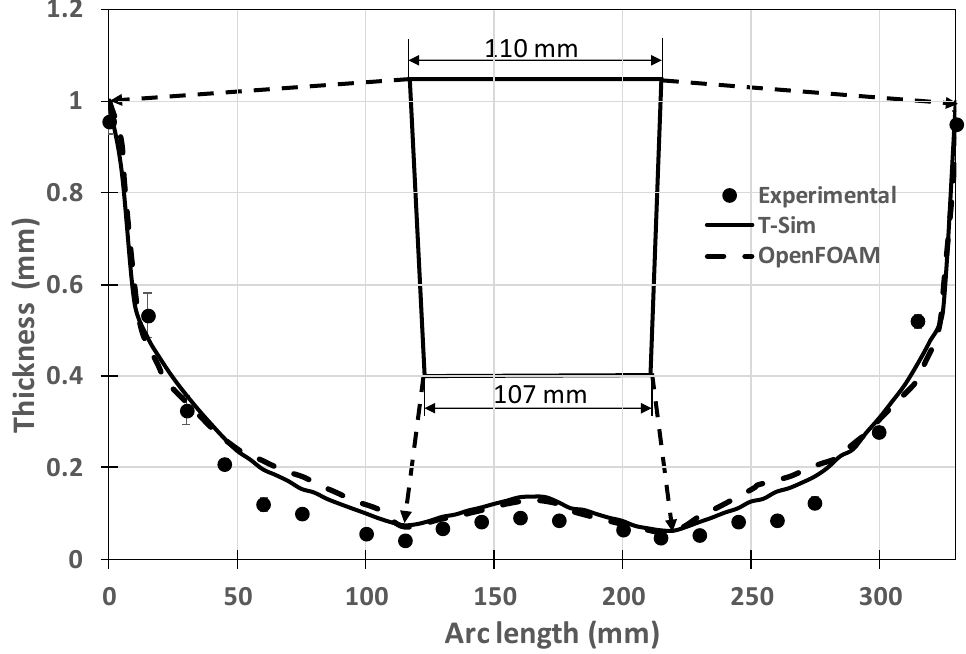
Figure 6. Experimental assessment of the computational results.